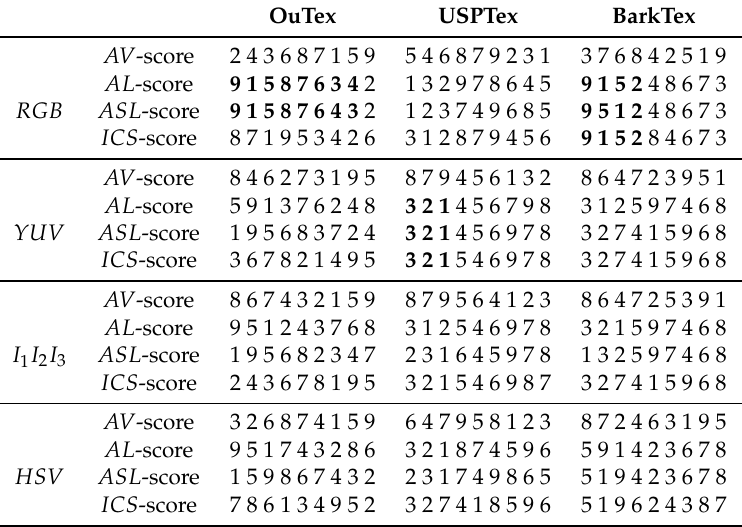
Table 5. Histogram ranks using the proposed scores with the different color spaces and for the three